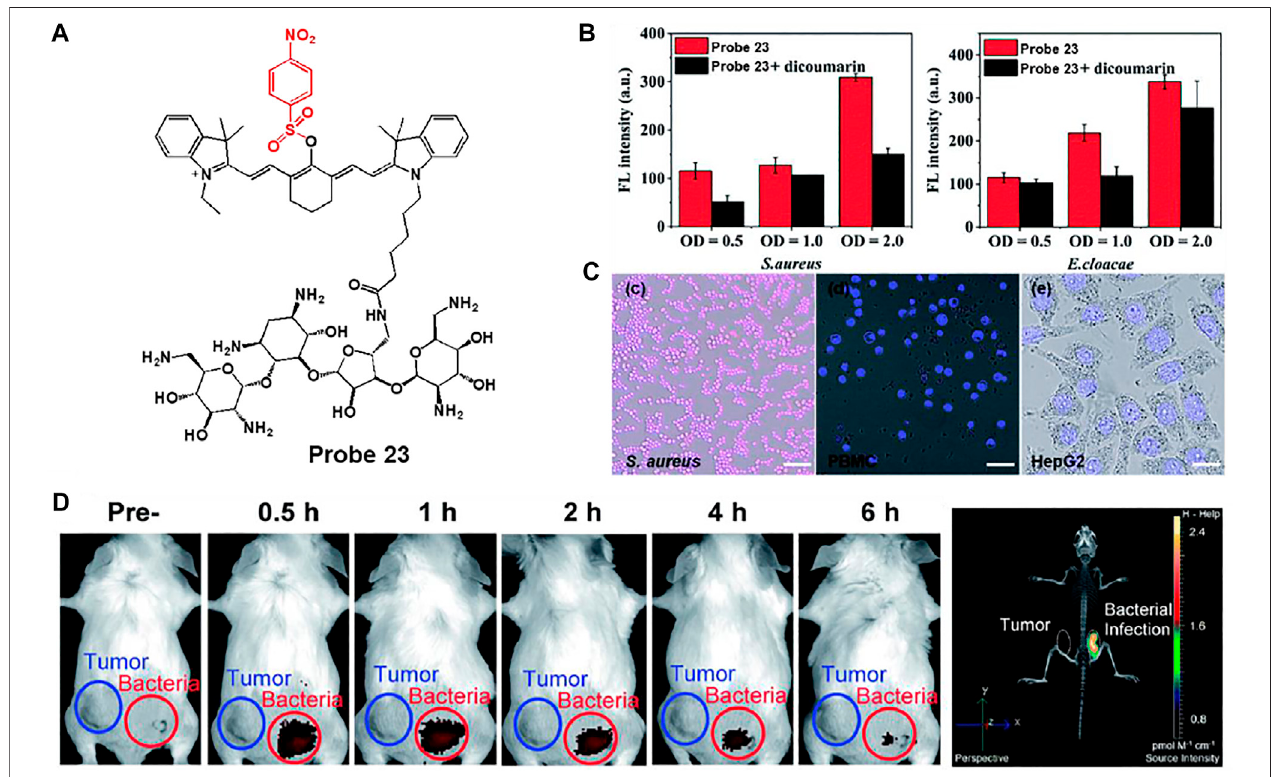
FIGURE 11 | (A) Chemical structure of probe 23. (B) Quanti fi cation of the fl uorescence intensity of probe 23 after incubation with S. aureus and E. cloacae in the presence(blackbars)orabsence(redbars)ofdicoumarin (C) Confocalmicroscopyimagesof S.aureus ,PBMCandHepG2incubatedwithprobe23. (D) Whole-mouse time-dependent images of CT26 tumor-bearing (blue circle) and S. aureus infected (red circle) mice before and post i.v. injection of probe 23. Reproduced with permission from Wu et al. (2020). Copyright © 2020, Royal Society of Chemistry.